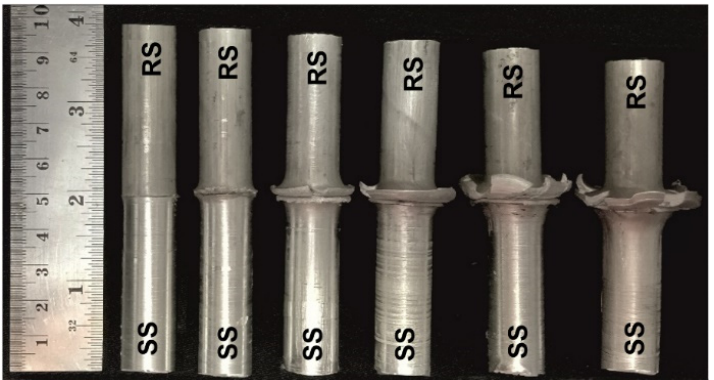
Figure 6. The dissimilar AA7075/AA5083 friction welded joints at different rotational speeds with AA7075 and AA5083 are positioned as rotary-side (RS) and stationary-side (SS) respectively. From left to right: 370, 540, 800, 1200, 1700 and 2500 rpm.